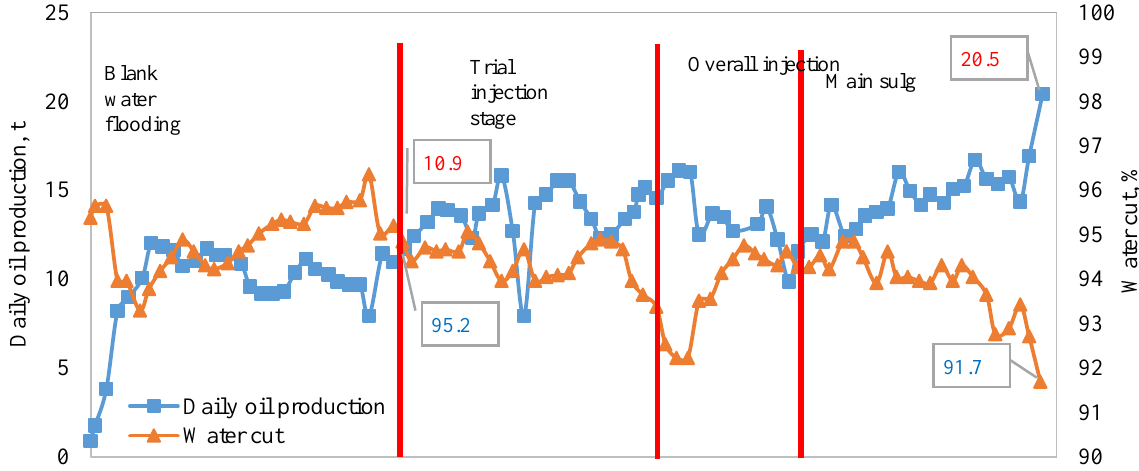
Figure 13—Daily oil production and water cut curve of the test